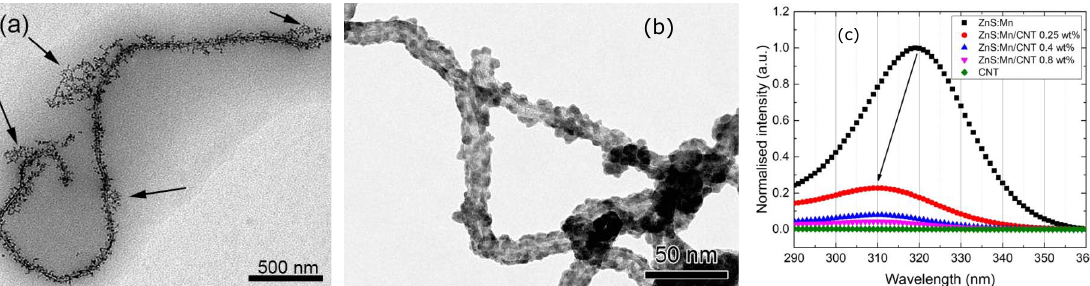
Figure 3. Nanocomposites prepared by heteroaggregation ( a ) or direct growth ( b ), spectral excitation shift after direct growth ( c ). All images reprinted from references [10,11] with permission from Elsevier